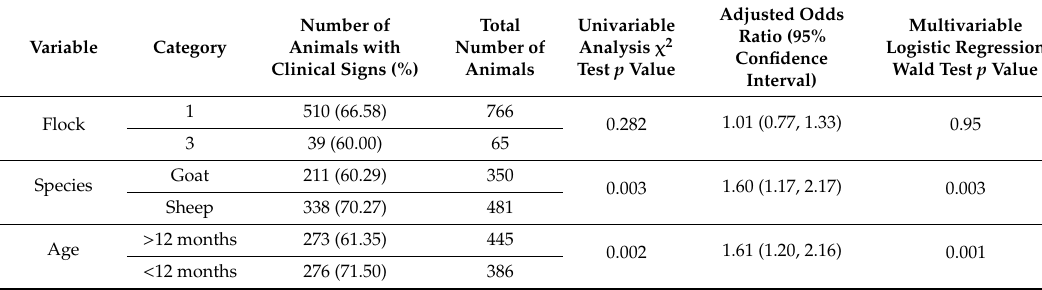
Table 2. Descriptive, univariable and multivariable analysis of the number of sheep and goats with clinical signs by species and age group in flocks 1 and 3 ( n =